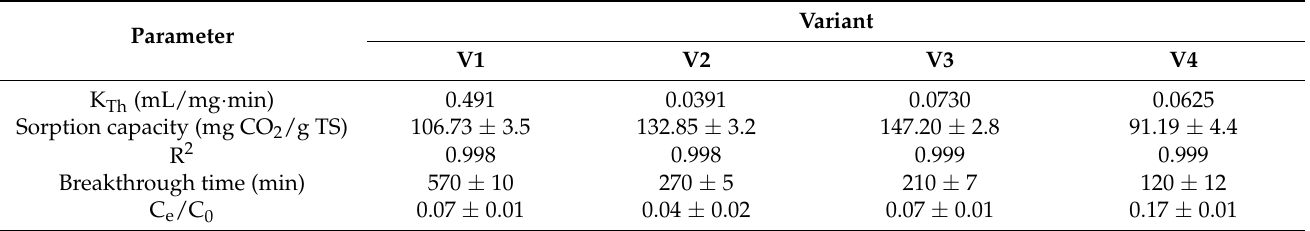
Table 2. Results of breakthrough curves and sorption capacities with the Thomas model for CO 2 sorption onto the bio-waste sorbent in a fixed-bed